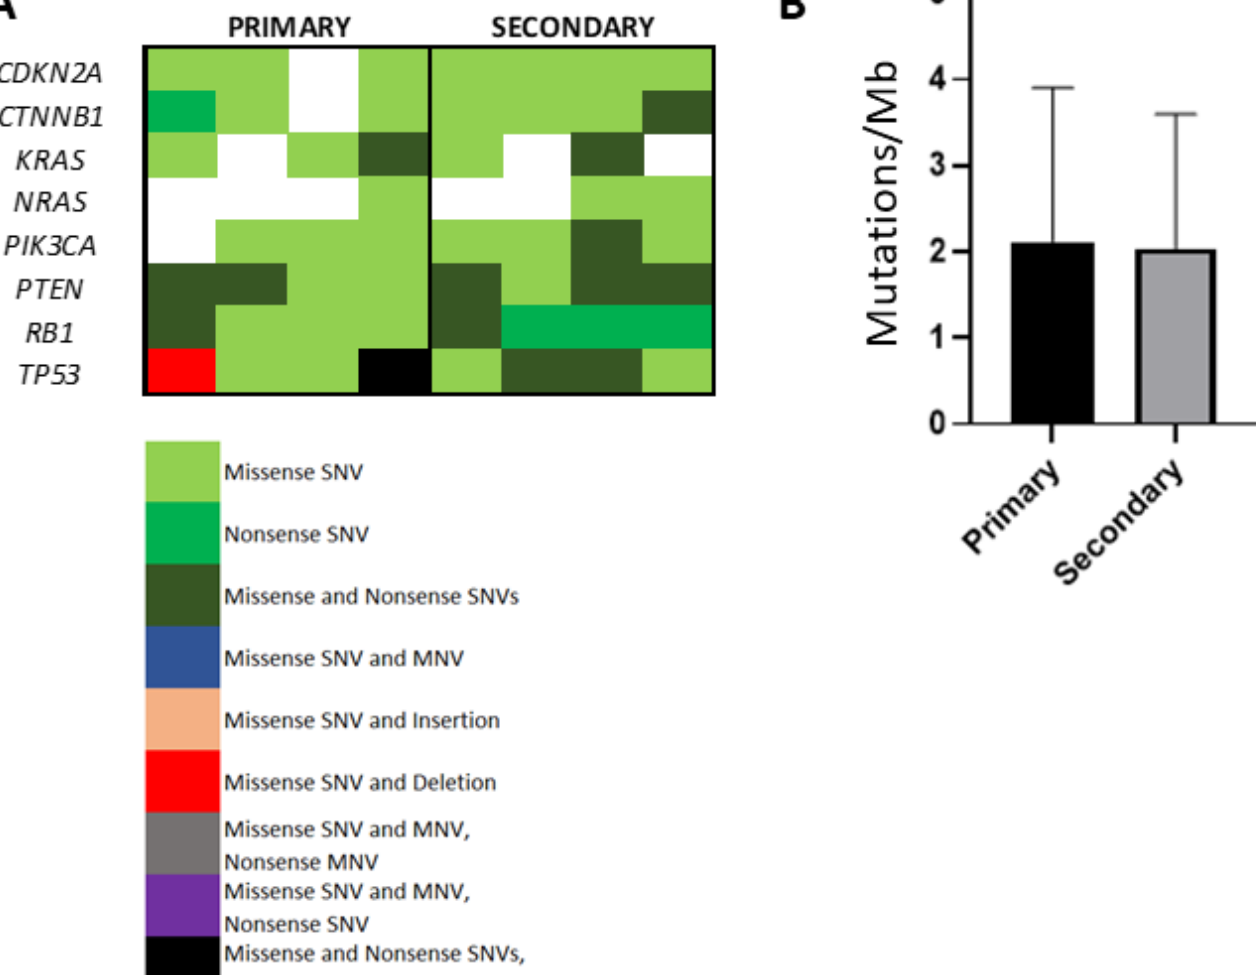
Figure 3. Comparison of the tumour mutational burden (TMB) in primary and secondary HCC lesions. Oncoplot of mutations in recurrently mutated genes in HCC, identified in primary and secondary samples ( A ). TMB estimates in primary and secondary samples, defined as the number of non-synonymous mutations per megabase of assayed genome ( B ).